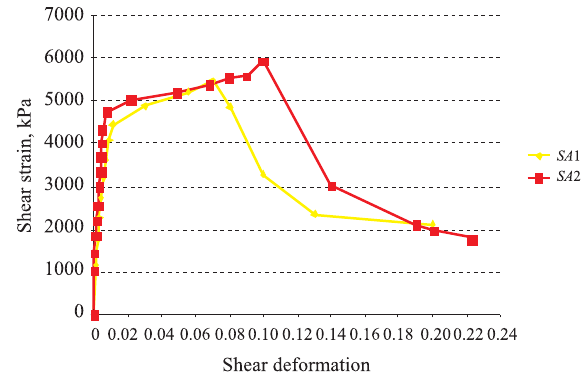
Fig. 10. Experimental results for SA 1 and SA 2 beams